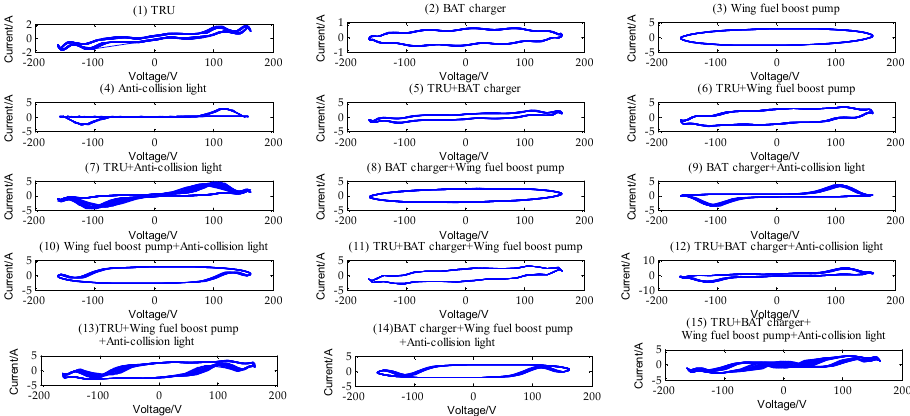
Figure 4. V-I trajectory of load working combination on RPDU1.